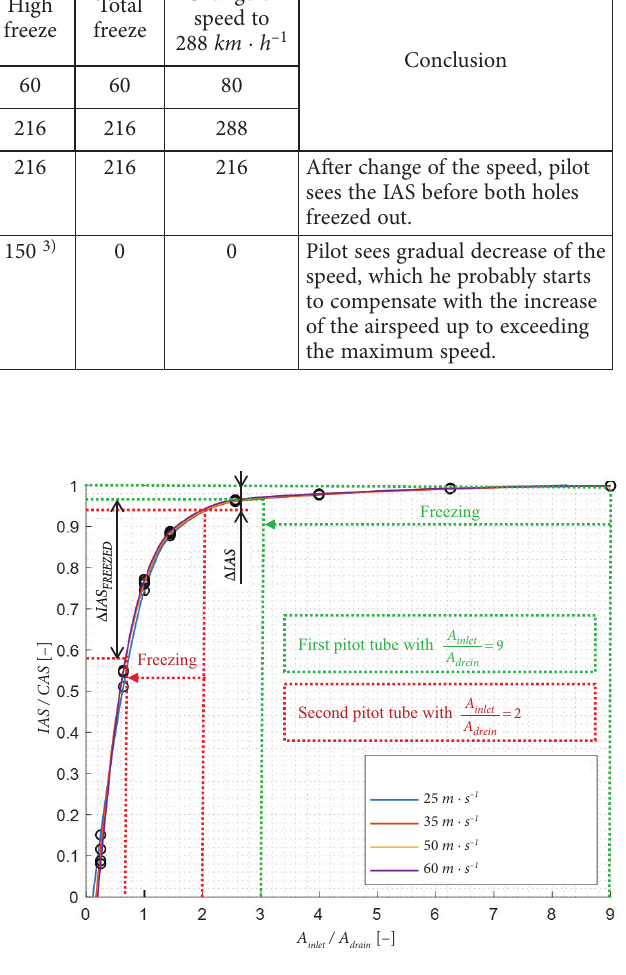
Figure 8. Gradual blocking curve IAS / CAS ratio A inlet / A drain ratio for a Pitot tube with 1 mm drain hole